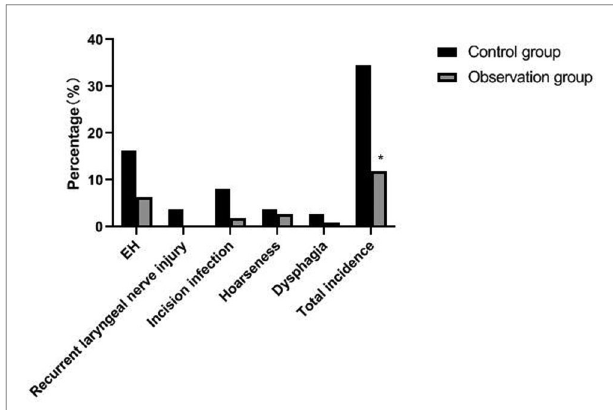
FIGURE 9 | Comparison of incidence of postoperative complications between the two groups. Note: compared with the control group, * p <0.05.